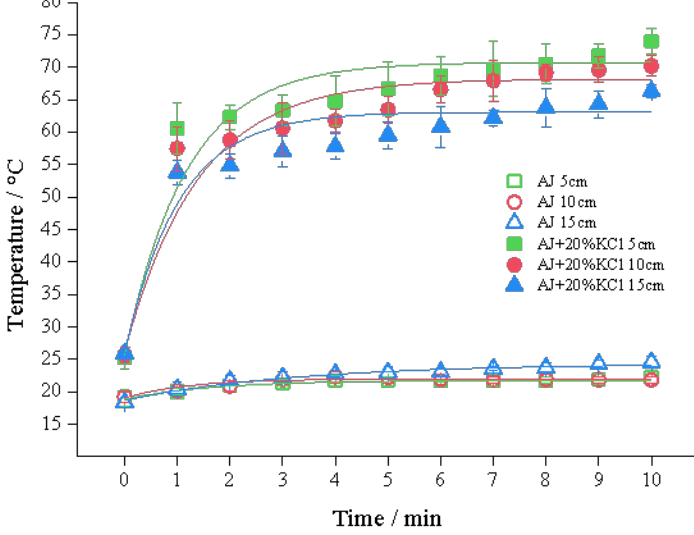
Figure 6. Effects of L 1 on temperature at 800 V, 400 Hz, d 1 = 2 mm, N S = 2 × 19.